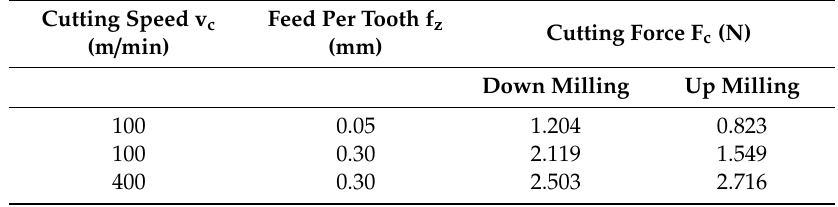
Table 9. Influence of cutting parameters on cutting force in peripheral milling (FE